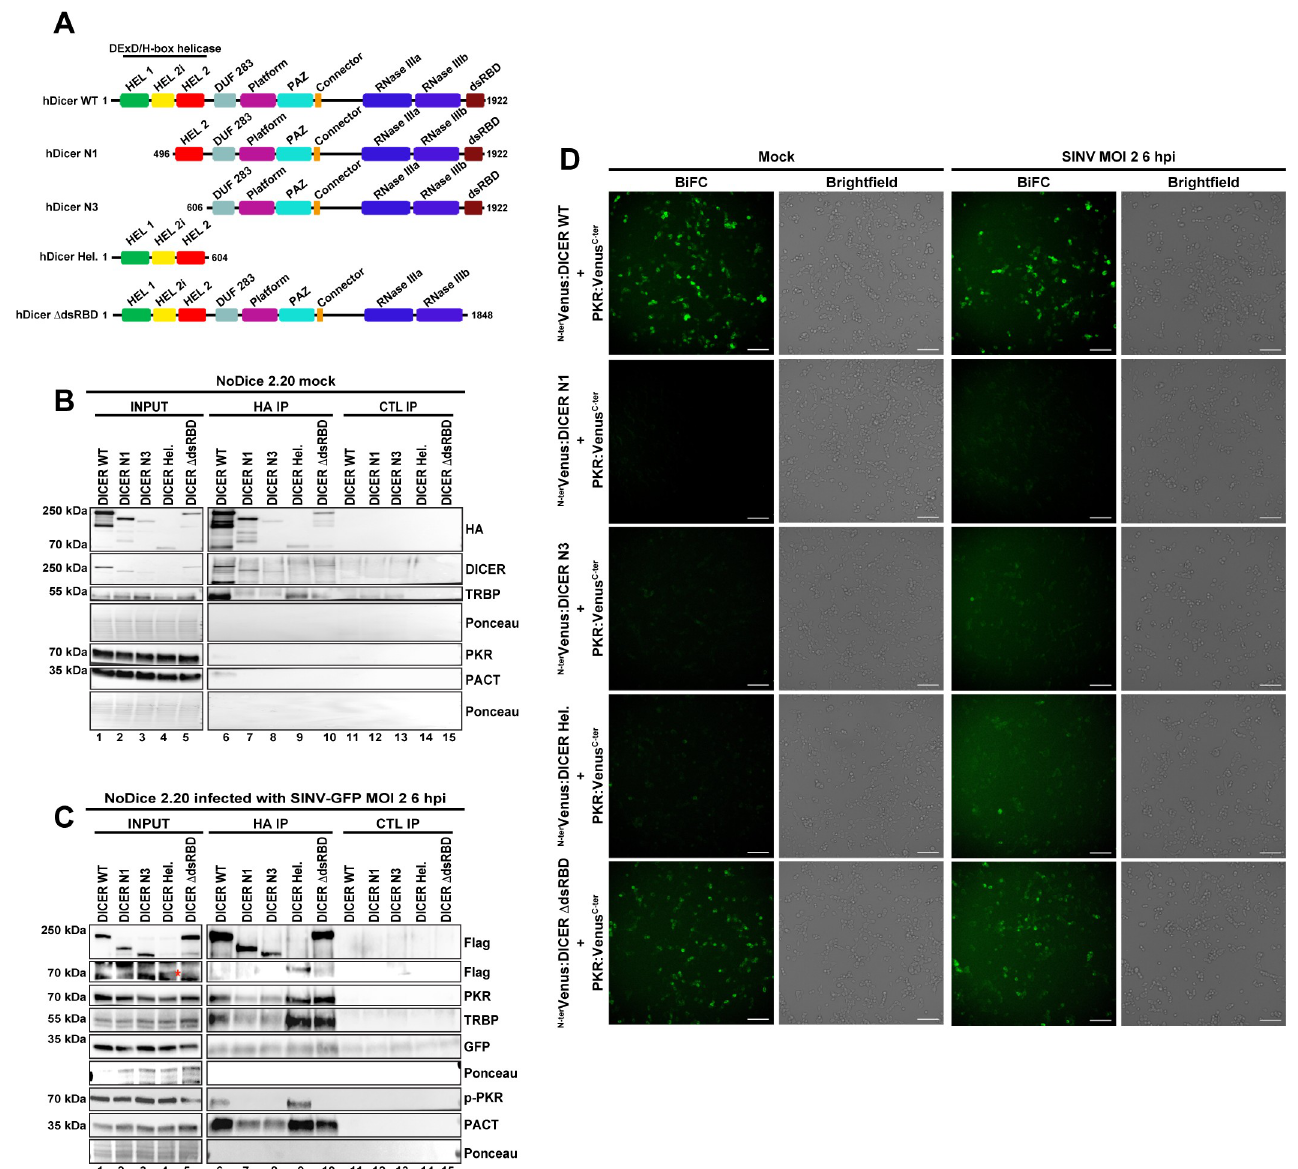
Fig 5. Identification of DICER domains involved in DICER-PKR interaction. A. Schematic representation of Human DICER proteins used in this study. The different conserved domains are shown in colored boxes. DUF283: Domain of Unknown Function; PAZ: PIWI ARGONAUTE ZWILLE domain; dsRBD: dsRNA-binding domain. hDICER WT is the full-length protein. hDICER N1 is deleted of the first N-terminal 495 amino acids. hDICER N3 is wholly deleted of the helicase domain. hDICER Hel. is the whole DICER’s helicase domain. hDICER Δ dsRBD is deleted of the C-terminal dsRBD. B. Western blot analysis of HA co-IP in mock NoDice 2.20 cells transfected with different versions of FHA:DICER proteins. Efficiency of immunoprecipitation was assessed using anti-HA and anti-DICER antibodies and co-IPs of TRBP, PKR and PACT were examined using appropriate antibodies. Expression of GFP in INPUT fraction was visualized as control of SINV-GFP infection. Ponceau staining of membranes is used as loading control. C. Western blot analysis of HA co-IP in NoDice 2.20 cells transfected with different versions of FHA:DICER proteins and infected with SINV-GFP (MOI of 2, 6 hpi). Efficiency of immunoprecipitation was assessed using an anti-Flag antibody and co-IPs of PKR, TRBP, p-PKR and PACT were examined using appropriate antibodies. Expression of GFP in INPUT fraction was visualized as control of SINV-GFP infection. Ponceau staining of membranes is used as loading control. The DICER Hel. band is indicated by a red asterisk. D. Plasmids expressing the different versions of DICER proteins fused to the N-terminal part of Venus and PKR:Venus C-ter plasmid were co-transfected in NoDice Δ PKR cells. Cells were treated as in Fig 3D. The different combinations are noted on the left side. The fluorescent signal was observed using an epifluorescence microscope. For each condition, the left panel corresponds to Venus signal and the right panel to the corresponding brightfield pictures. Scale bar: 100 μ m. hpi: hours post-infection.